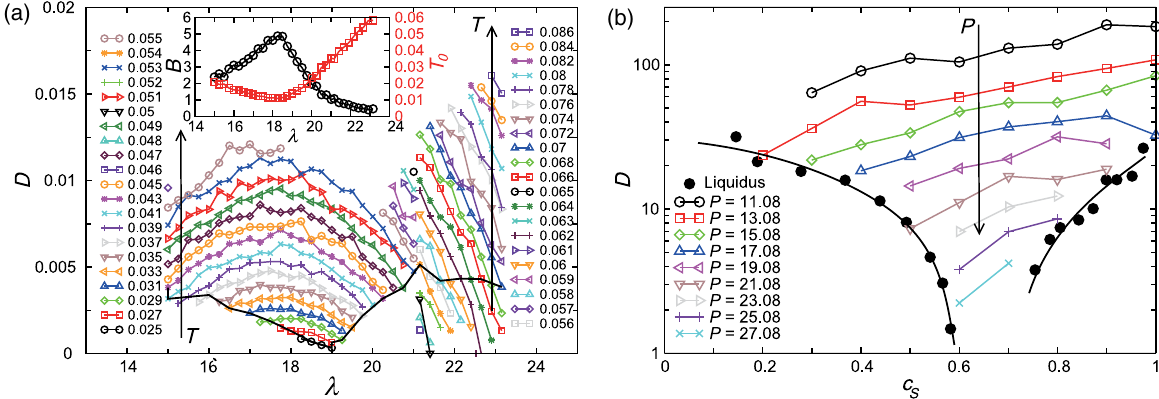
FIG. 2. Diffusion coefficients. (a) λ dependence of the diffusion coefficient ( D ) for different isotherms, i.e., at constant T (symbols) for the SW system. The continuous (black) line denotes state points with β Δ μ ¼ 0 . 6 [see Fig. 1(a)]. The inset shows the values for the fragility index ( B ) and for the Kauzmann temperature ( T 0 ) obtained from fitting the diffusion coefficients to a VFT relation (see text). See Appendix B 2 and Fig. 9 for the behavior of isodiffusivity lines. (b) c dependence of the diffusion coefficient ( D ) for different S isobars (open symbols) for the BD system. The diffusion coefficient along the liquidus line is plotted with full symbols. Pressure is in 1 and β ¼ 1 adimensional units with σ L ¼